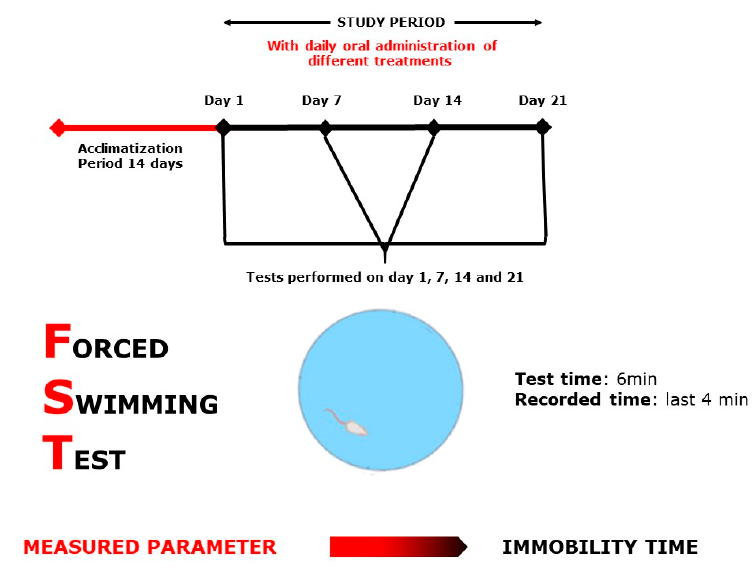
Figure 9. Forced Swimming Test scheme.